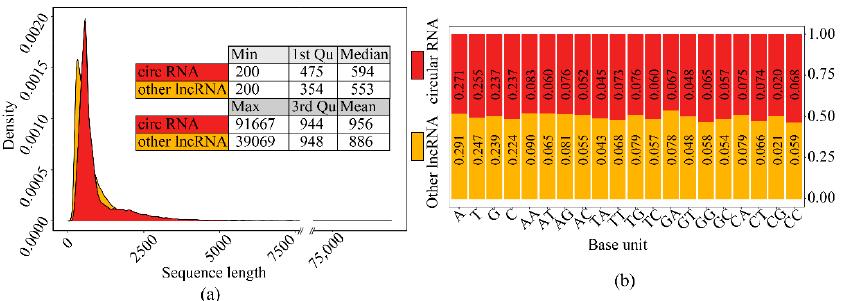
Figure 5. The comparison of simple features of sequences between the two ‐ type sequence set: ( a ) Sequence length distribution comparison. ( b ) Sequence composition comparison.